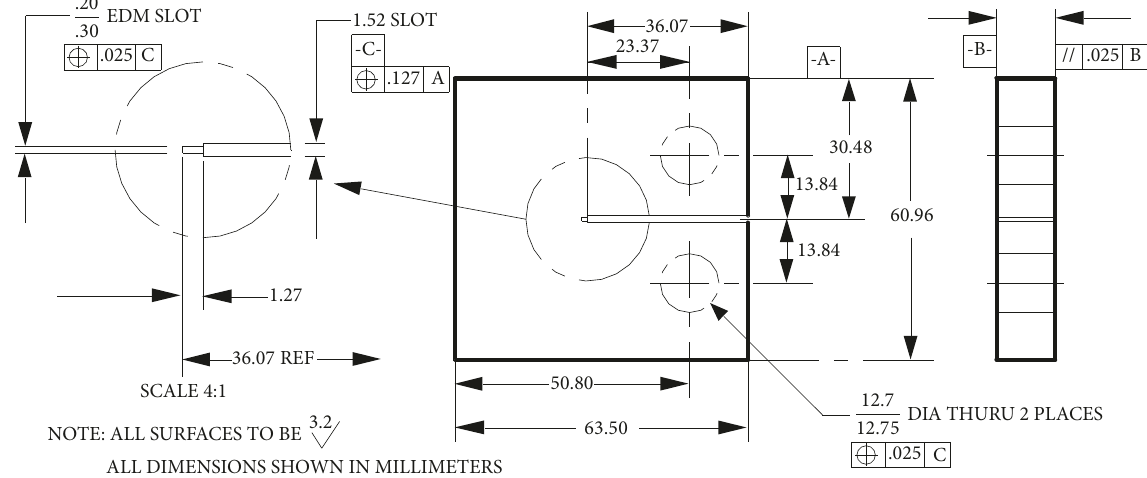
Figure 2: CT specimens used in the SCC experiments (all dimensions are in